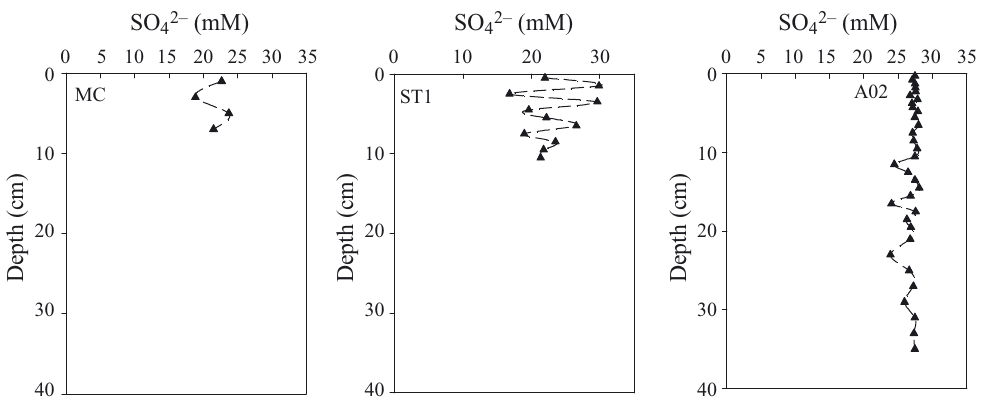
Fig. 4. Pore water profiles of sulfate at Stns ST1, MC, and A02 in Sanggou Bay (see Fig. 1 for station locations)